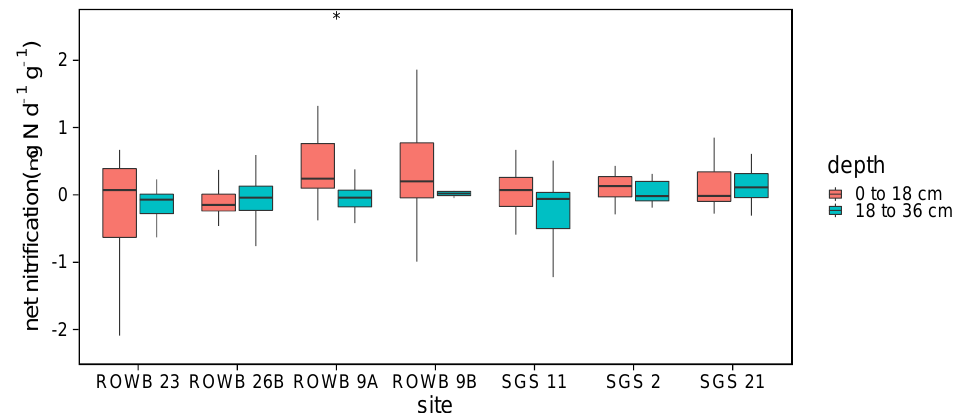
Figure 4. Net mineralization rates ( µ g nitrogen (N) d − 1 g − 1 dry soil) as calculated in Equation (1) quantifying differences between initial and one-week incubations for all soil cores at seven bioswales sampled at two depths ( n = 209). * signifies bioswales where shallow (0 to 18 cm) and deep (18 to 36 cm) samples were statistically different. ROWB: right-of-way bioswale; SGS: stormwater greenstreet.